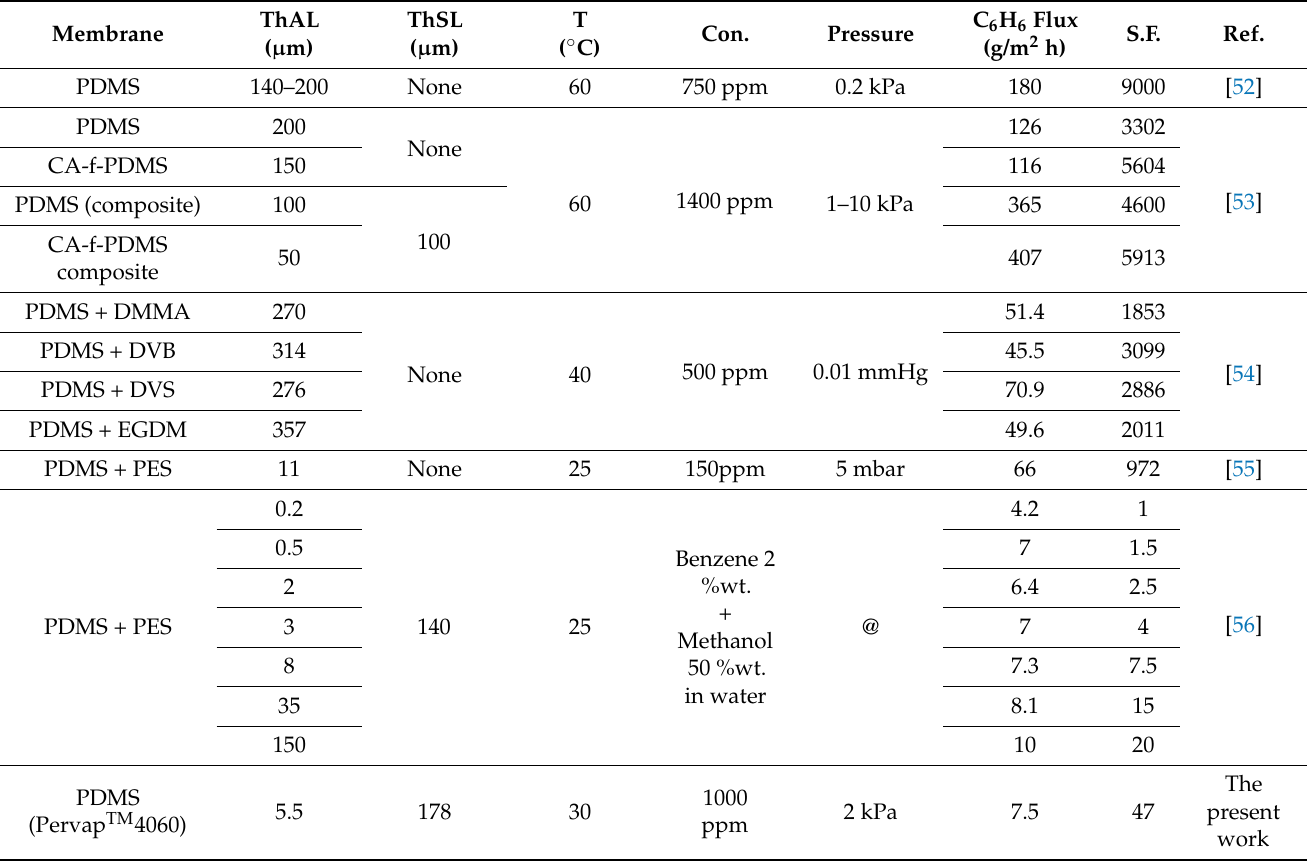
Table 2. The performance of the present and previous PV processes for benzene recovery from an aqueous